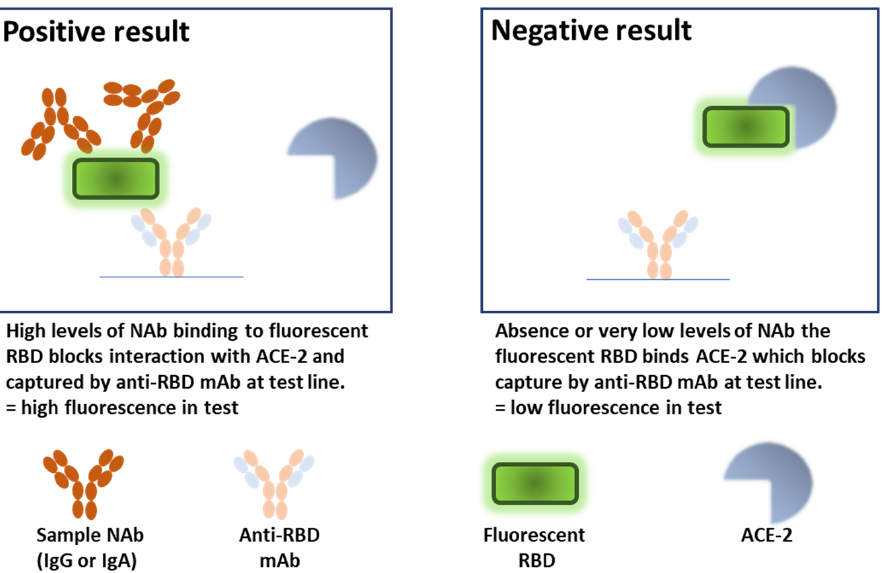
Figure 1. Schematic overview of PL-NAb test function. NAb in test sample bind to fluorescent SARS-CoV-2-RBD that is captured at the test line by specific mAb, causing a fluorescence signal proportional to level of NAb to be detected ( left panel ). In the absence of NAb within samples, the fluorescent RBD molecule is free to bind to ACE-2. This interaction blocks the capture at the test line, resulting in a low fluorescent signal ( right panel ). Graphics are not drawn to scale.